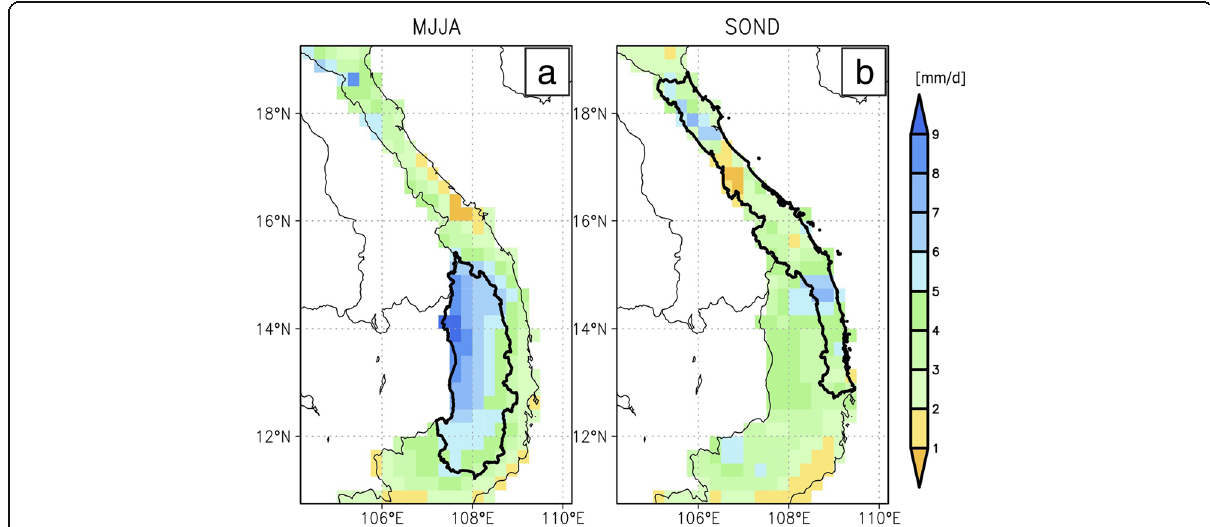
Fig. 3 Spatial patterns of SPDs ’ rainfall difference between maximum and minimum values among the three SPDs at each grid point in Central Vietnam, averaged for a MJJA and b SOND in 2001 – 2010. The VCH and the VCC are surrounded by black thick lines in a MJJA and b SOND patterns,